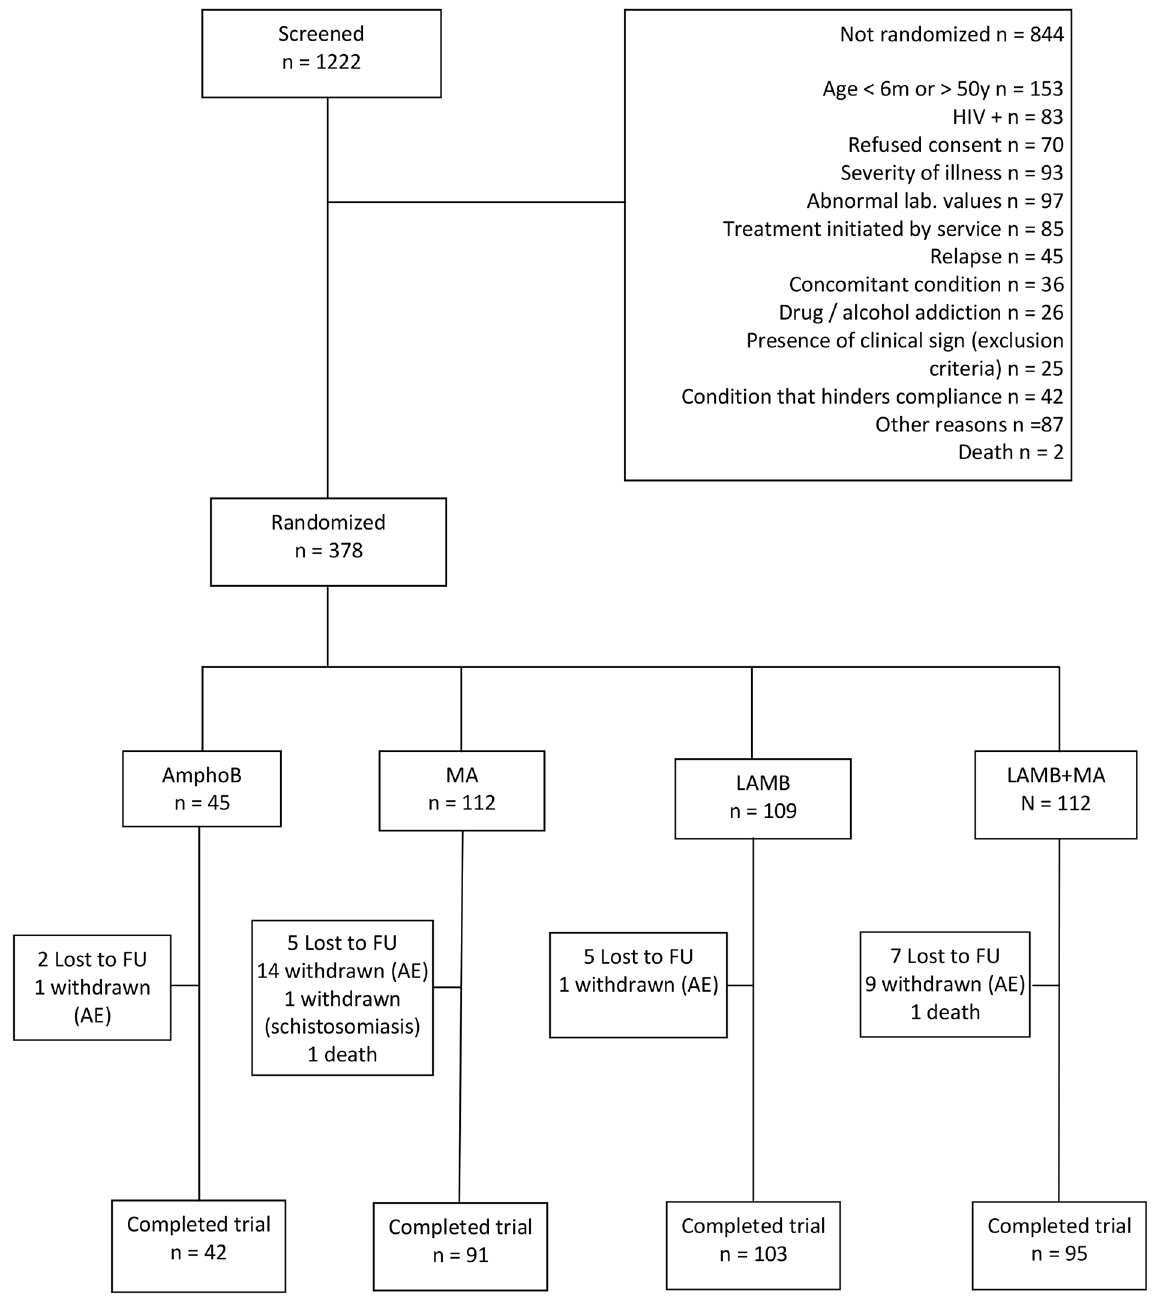
Fig 1. CONSORT patient flowchart. Flow diagram of the progress through the phases of the trial. AmphoB= amphotericin B deoxycholate; MA = meglumineantimoniate; LAMB = Liposomalamphotericin B. Nine participants had their six months follow-up visit after the allowed window (ranging from one day to 43 days) and were included in the ITT analysis as cured since if they were free of relapse after the allowed period, they were also free of relapse at 6 months. One patient had the six months visit 12 days before the allowed window, and as it was verified that he continued to be free of relapse after 6 months, he was also considered as cured for ITT analysis.